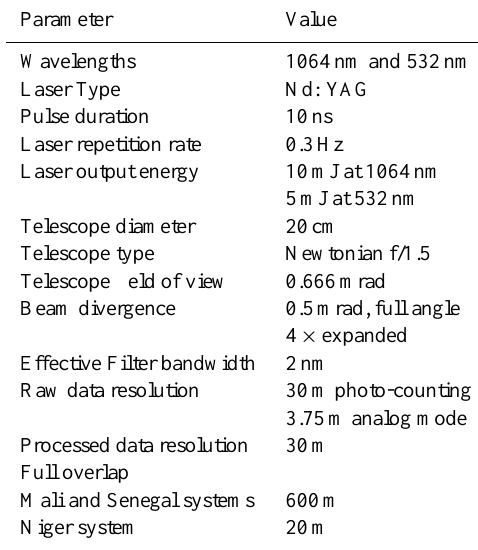
Table 2. Parameters of the MULID